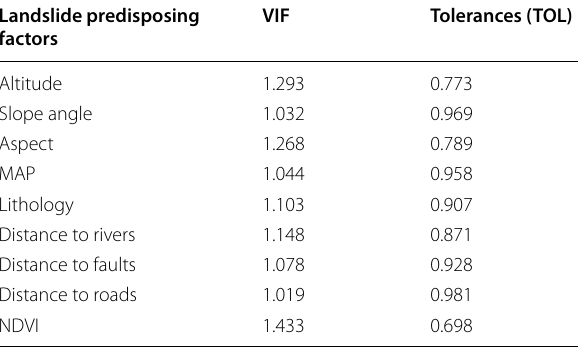
Table 5 The VIF and TOL values of each landslide predisposing